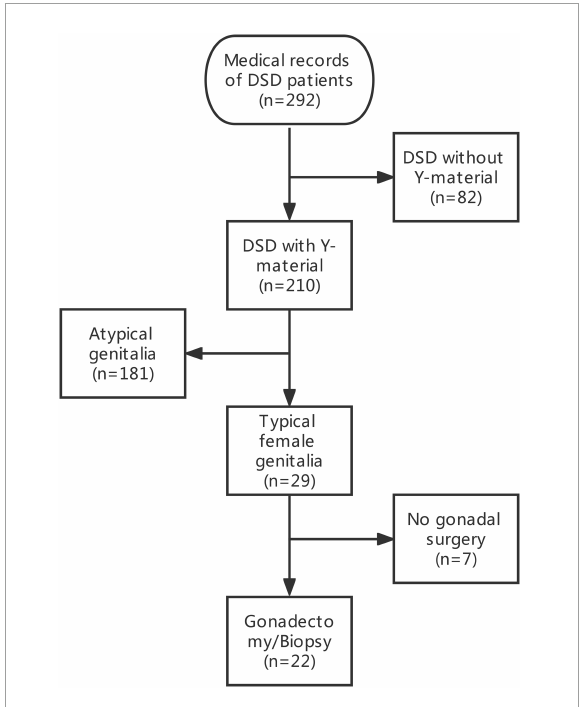
FIGURE1 Flow diagram of section of patients with DSD according to the inclusion